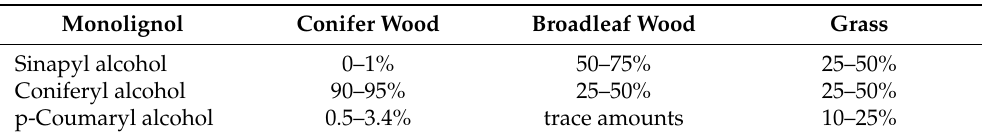
Figure 1. Precursor monolignols and lignin structure resulting from the plant source. Reproduced from [13], with the permission of Elsevier. Table 2. Monolignol content in different plant sources. Reproduced from [12], with the permission of the American Chemical Society.